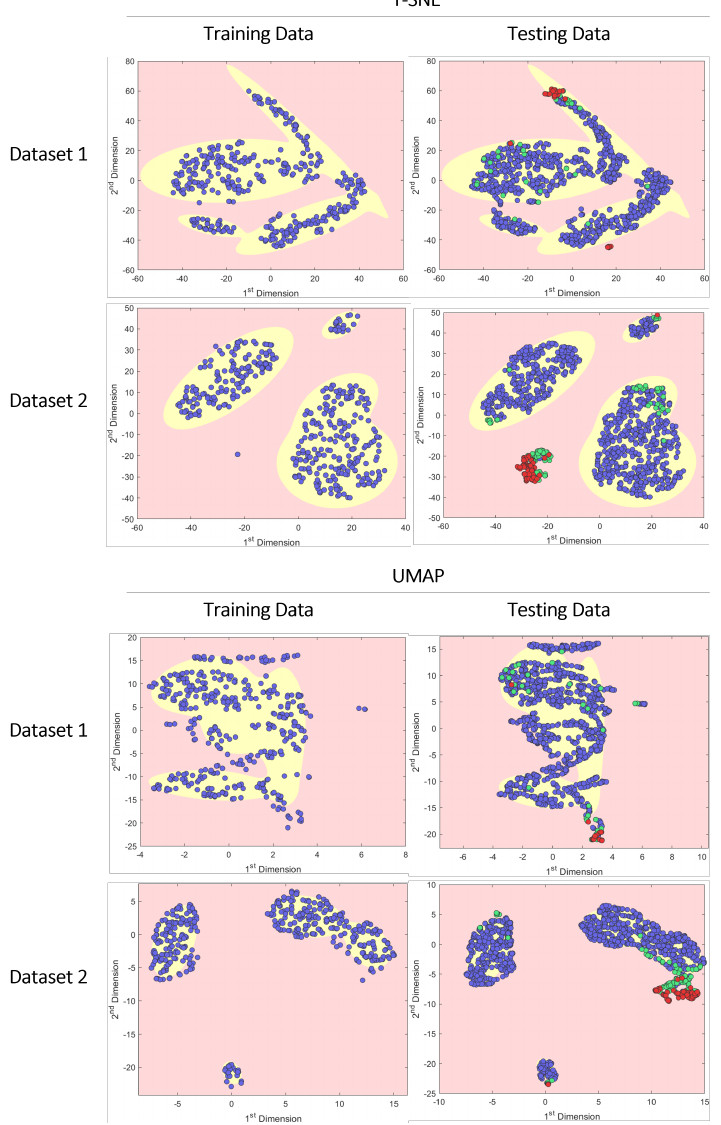
Figure 6. The same GMM approach applied using t-SNE and UMAP to reduce and cluster the data. Labelled data include Nominal points (blue), ANC (green), and True Anomalies